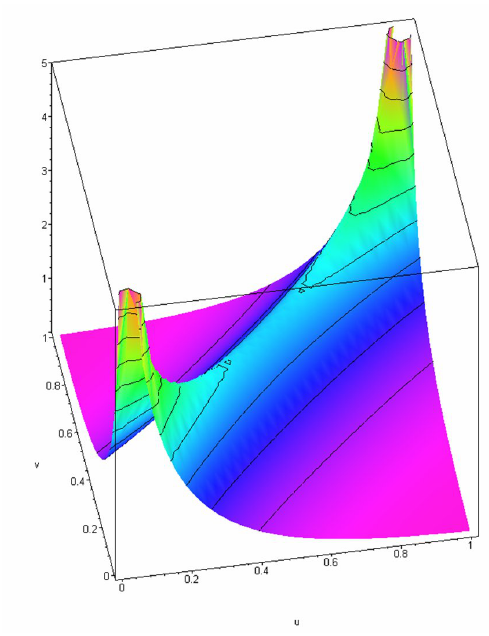
Figure 12: Power copula density c P 3 ( u , v ) , diagonal Figure 13: Power copula density c P 5 ( u , v ) ,